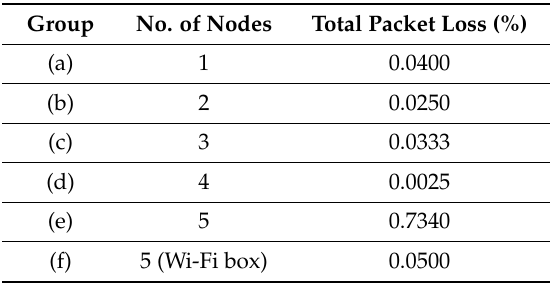
Figure 7. Distribution of packets lost with increasing number of devices simultaneously sending data through a Google Nexus 6 Plus mobile phone ( a – e ), and five devices simultaneously sending data through an O2 wireless box IV ( f ). The red “*” symbol represents a dropped packet and the blue “.” symbol represents a received packet. The number to the right of each trace shows the number of dropped packets for that board. Each board sends 10,000 packets at a sample rate of 100 Hz, giving a total sample time of 100 s. Table 5. Summary of packet loss for different node